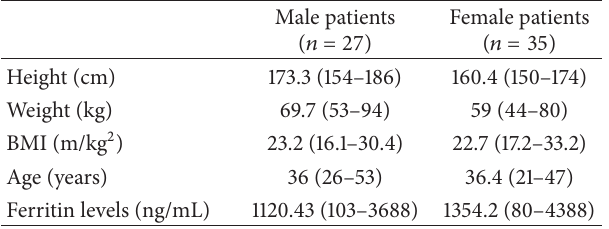
Table 1: Characteristics of patients with thalassemia major.